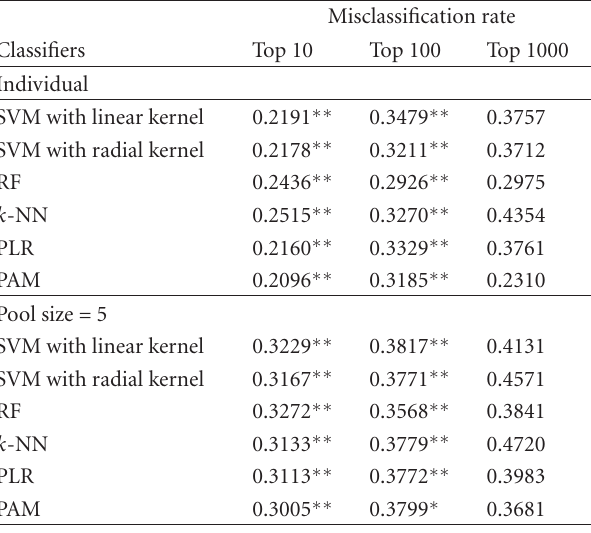
Table 1: Comparison of classification performance with di ff erent numbers of top-ranked